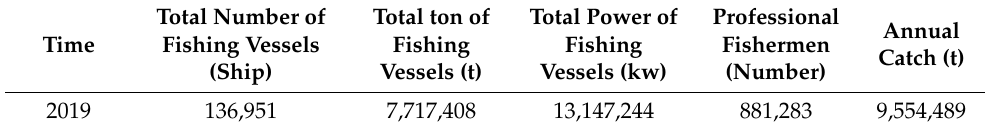
Table 5. Calculation of Polynomial